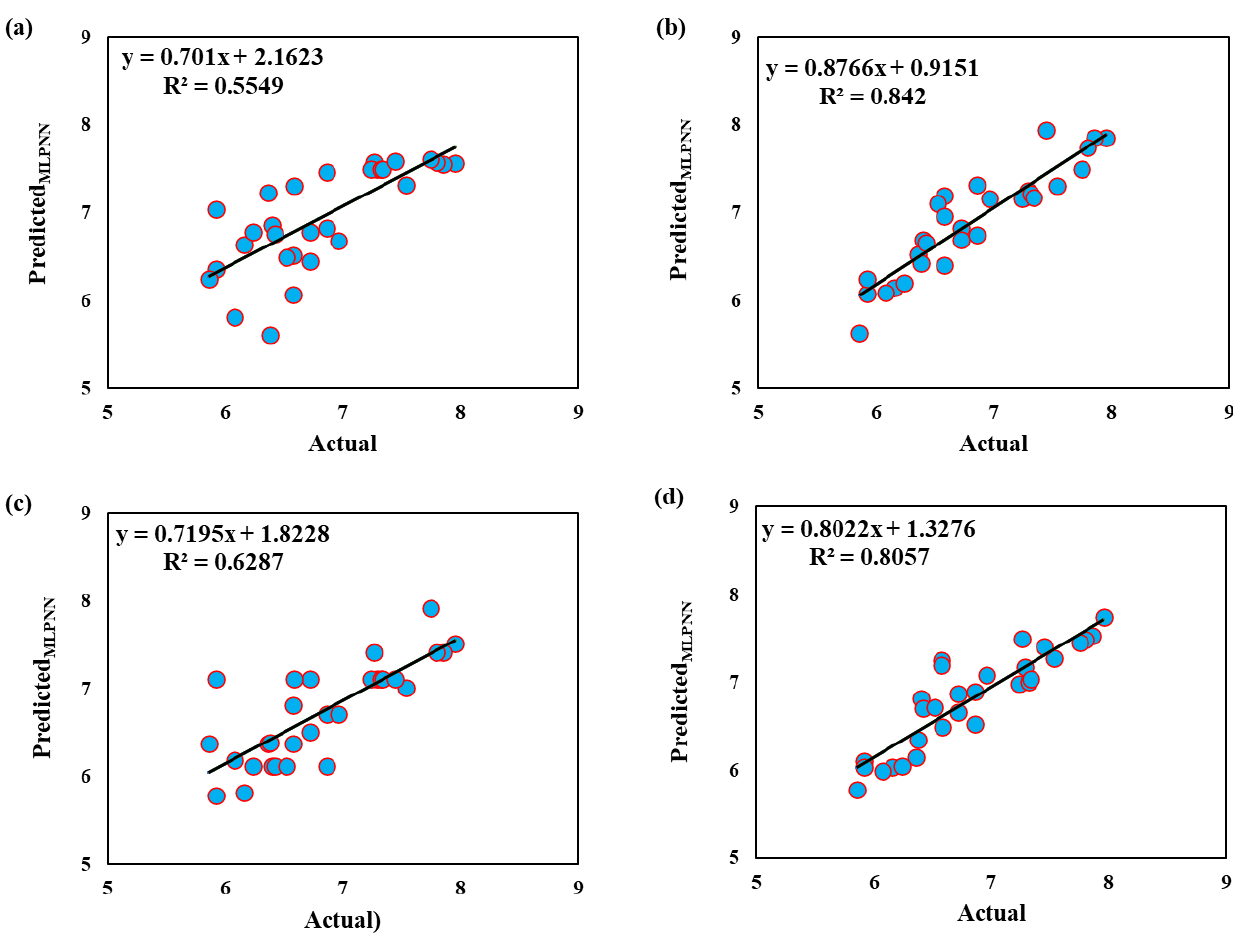
Figure 3. Scatter Plots for the MLNN method: ( a ) Model-1; ( b ) Model-2; ( c ) Model-3; and ( d ) Model-4, respectively.